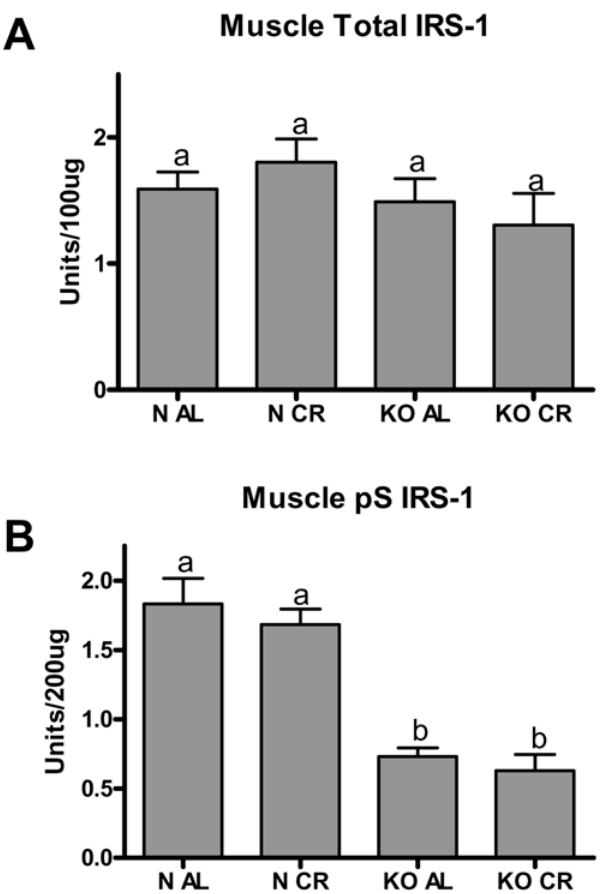
Figure 6. Muscle total mTOR protein (A) and mTOR pS2448 (B) in GHRKO (KO) and normal (N) mice fed adlibitum (AL) or 30% calorie restriction (CR) for one year were determined using western blotting. Bars represent 6–8 animals per phenotype/diet group.